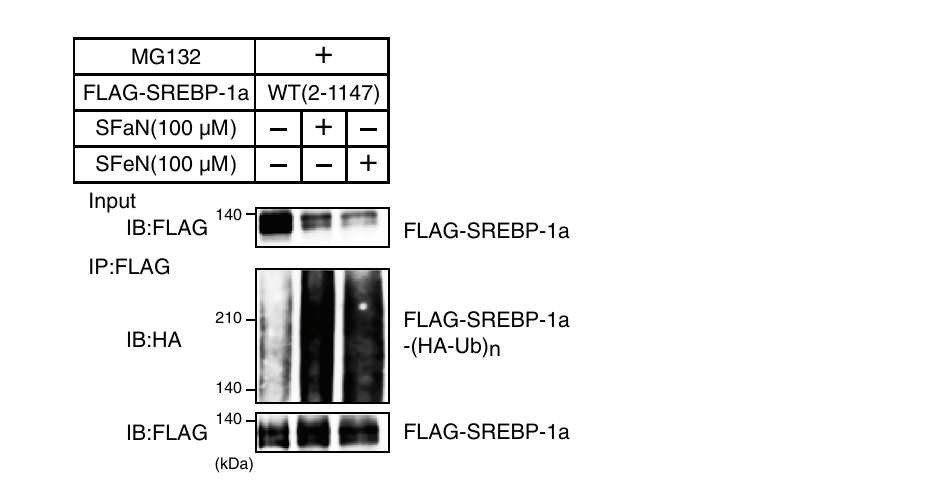
Figure 8. Ubiquitination of SREBP-1a is stimulated by SFaN. Huh-7 cells were transfected with pCMV- SREBP-1a-(2–1147) -3 × FLAG and HA-Ub and cultured in medium B for 24 h. The cells were trypsinized and seeded in 100 mm dishes and cultured in medium B for 24 h. After incubation with 10 μM MG132 for 30 min, the cells were shifted into medium B supplemented with 10 μM MG132 in the presence of vehicle, 100 μM SFaN, or SFeN. After incubation for 3 h, cell lysates were subjected to immunoprecipitation (IP) using an anti- FLAG antibody. The immunoprecipitates were subjected to immunoblotting (IB) with anti-HA or anti-FLAG antibodies. Full-length images are presented in Supplementary Fig.